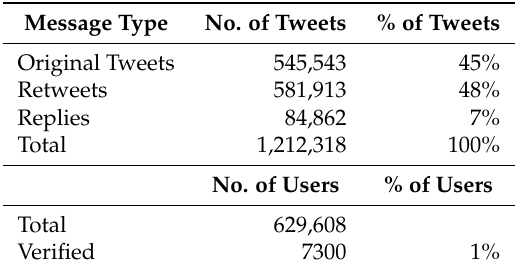
Table 1. Dataset